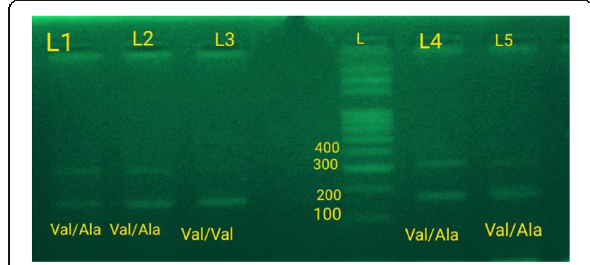
Fig. 2 Genotyping of the SOD2 gene (L = 100 bp ladder DNA marker) (Val/Val: homozygous wild-type and Val/Ala: heterozygous-genotype). (L=lane)